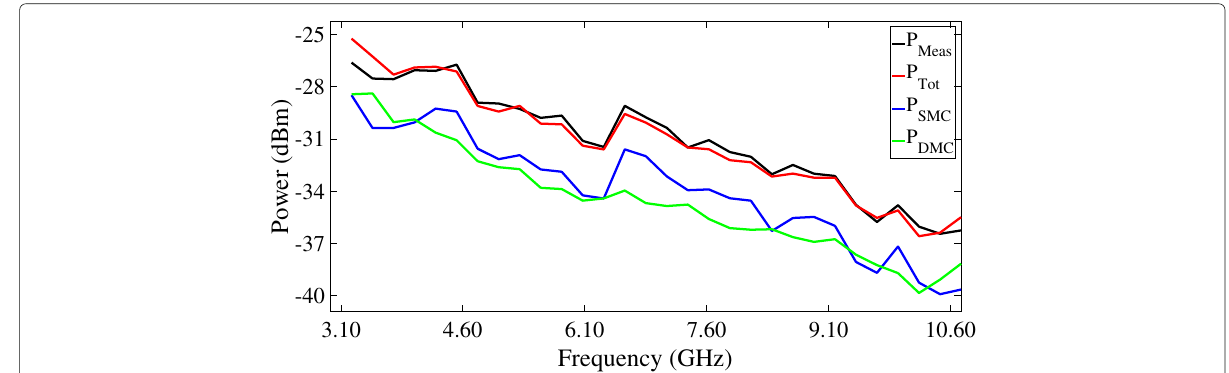
Fig. 17 Mean values of the measured powers in the radio channel as a function of UWB frequencies: OLoS